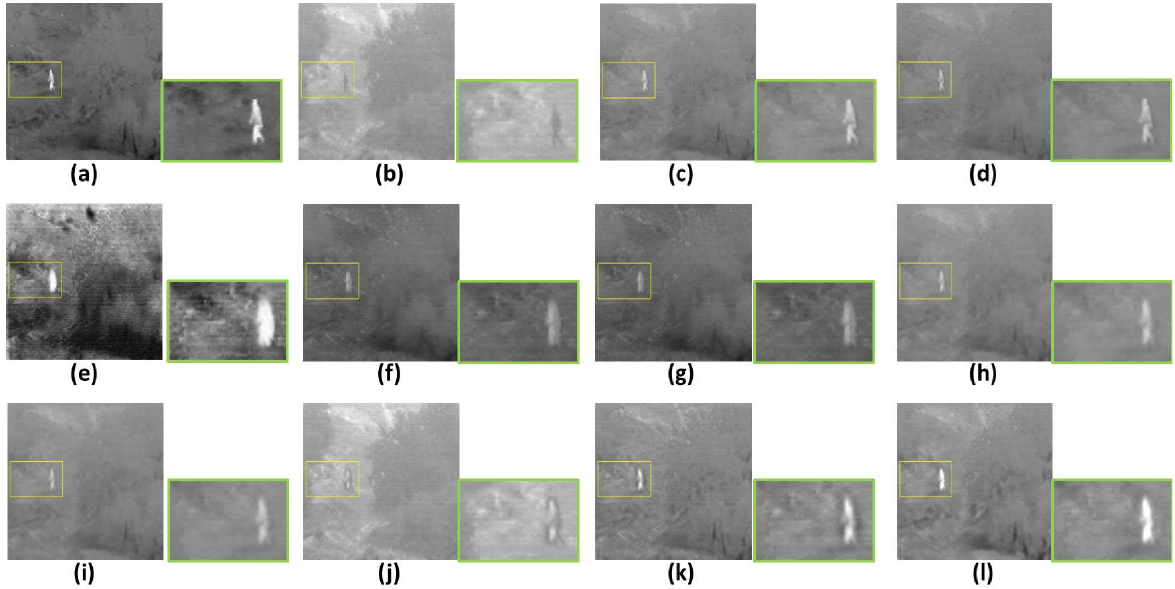
Figure 4. Visual IF results of different methods on tree sequence : ( a ) IR image, ( b ) VIS image, ( c ) Pro- posed method, ( d ) [17], ( e ) [22], ( f ) [33], ( g ) [20], ( h ) [34], ( i ) [35], ( j ) [36], ( k ) [37], and ( l )